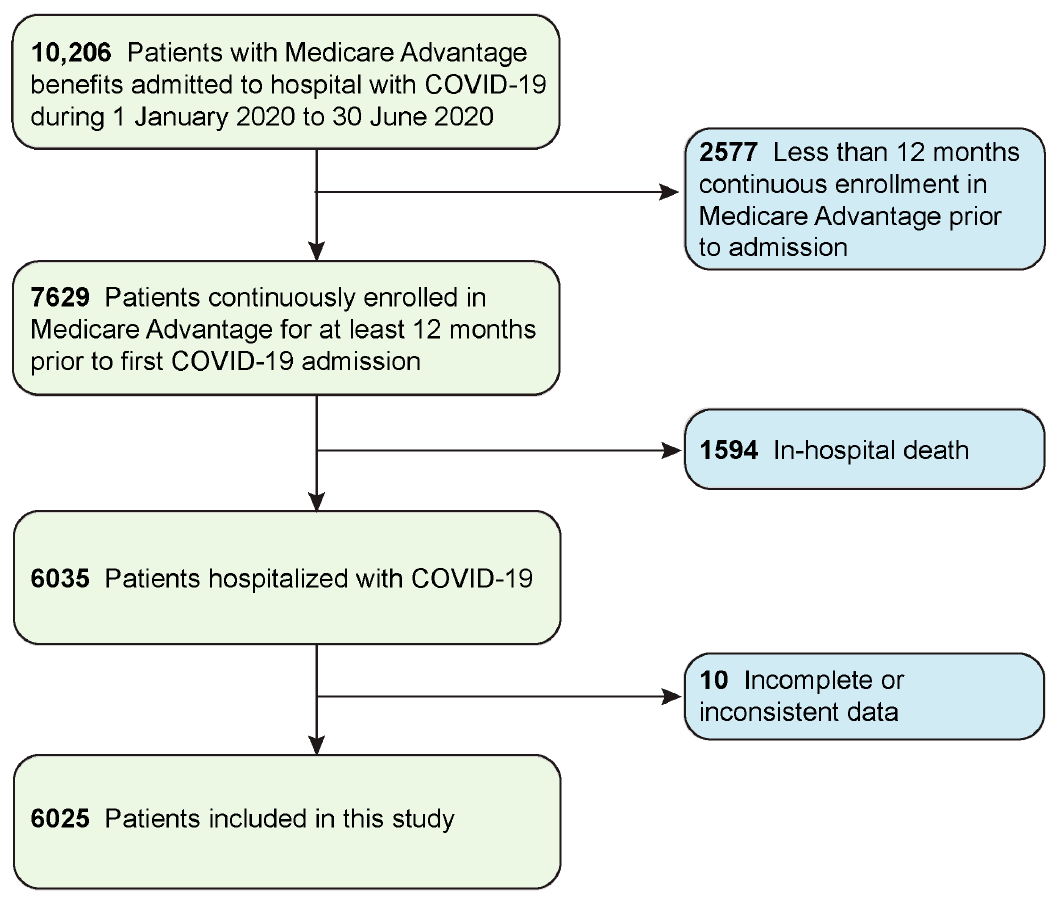
Figure 1. Selection of study patients.